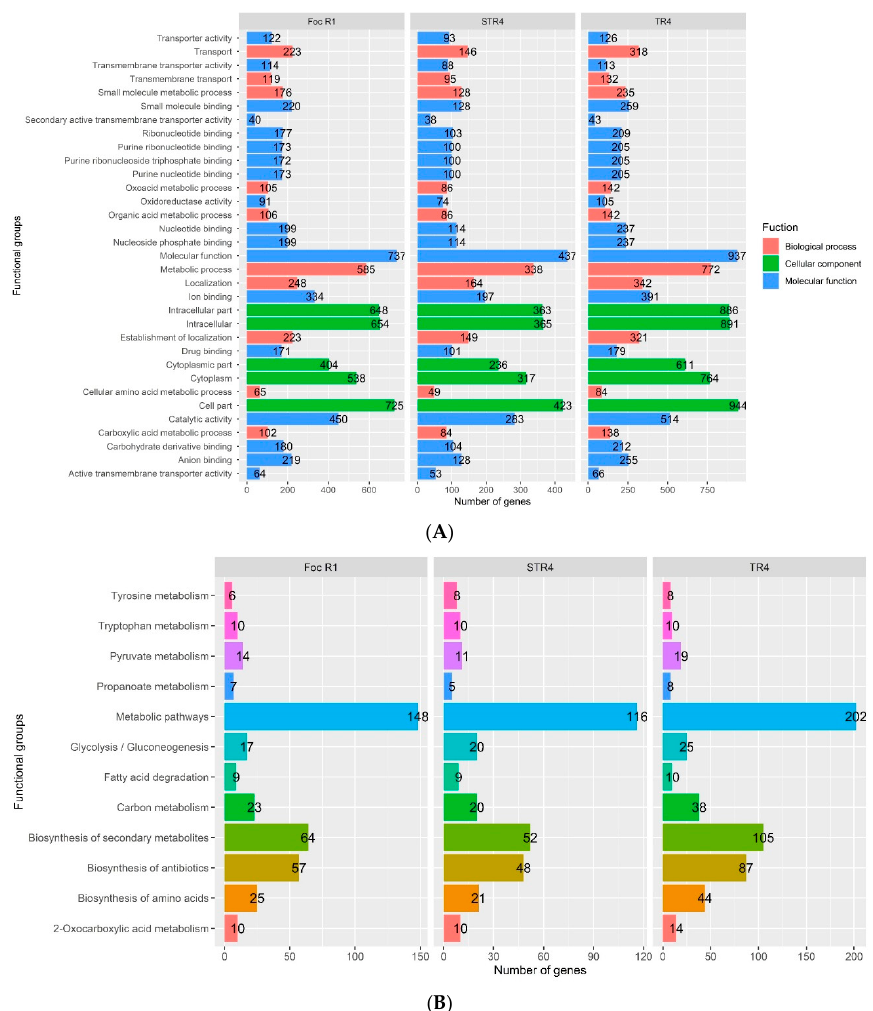
Figure 2. Functional annotation of the Indian VCGs of Foc genome assemblies based on COG ( A ) and KEGG ( B ). The colour in the bar represents the respective functional groups in the y -axis and value represents the number of genes identified from the respective functional groups.